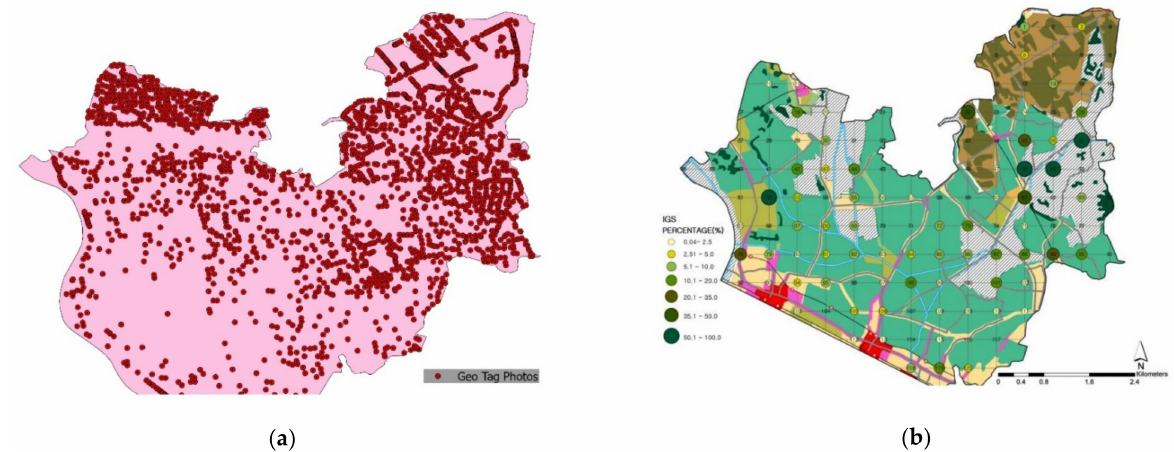
Figure 8. Distribution maps of IGSs in northern Ichikawa. The map from this study ( a ) indicates IGSs (red dots) with high densities in the northeastern and northern parts of the city, with lower densities in the southern parts of Ichikawa. The map ( b ) from Minseo Kim’s research [26] shows the percentage of IGSs found at each site shown in terms of the size and color of green circles, with the largest and darkest green shades indicating 50.1–100% and the smallest and brightest colors representing